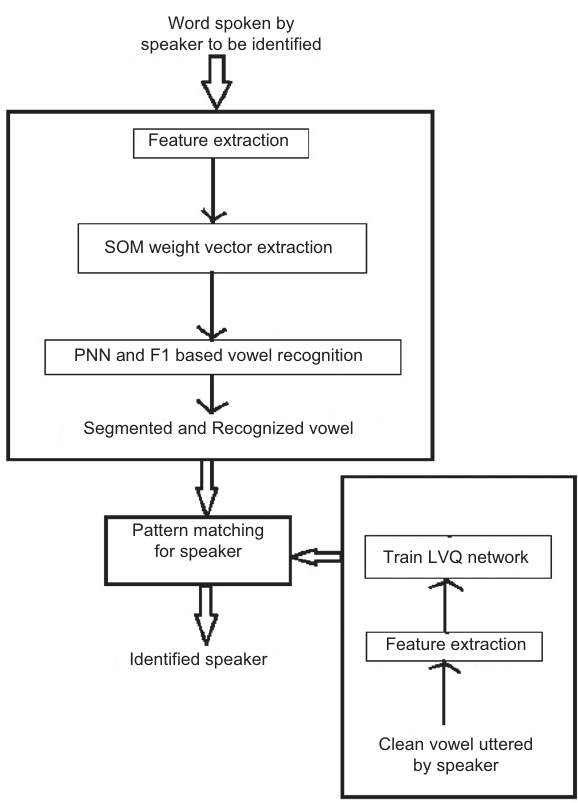
Figure 5. Process Logic of the Proposed